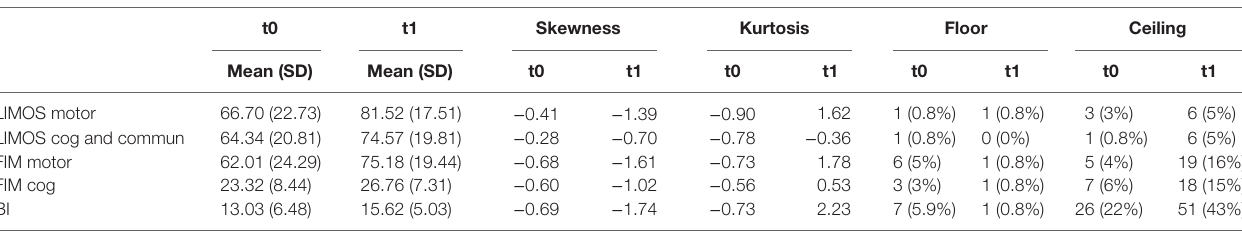
TaBle 1 | score distributions of the liMOs, FiM, and Bi scales. t0 t1